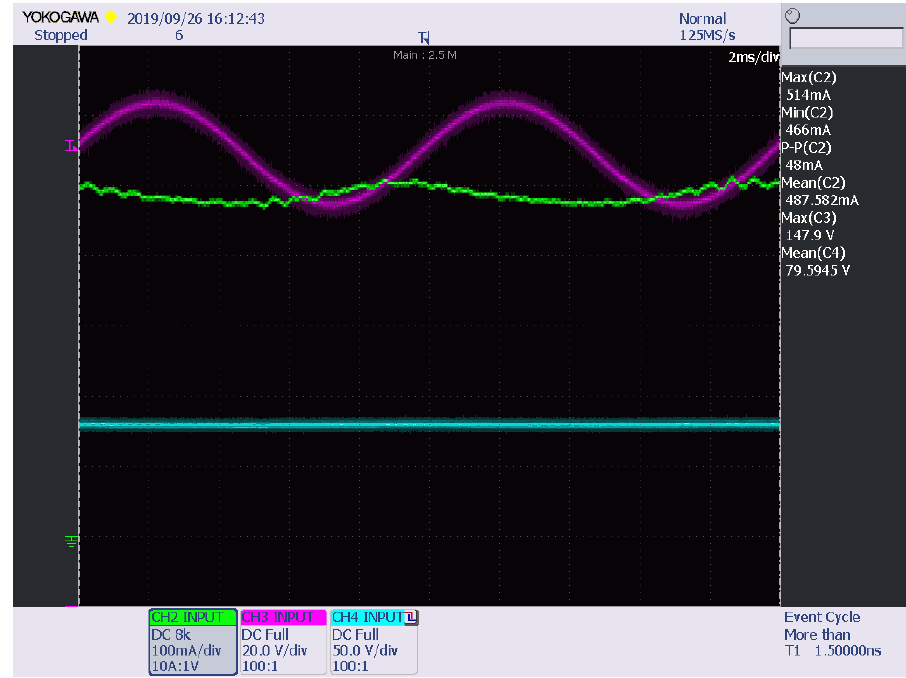
Figure 20. Experimental waveforms at nominal power with PI controller enabled. (4.9% ripple). Channel 2: LED current, green trace, 0.1 A/div; Channel 3: Bus voltage, magenta trace, 20 V/div; Channel 4: LED voltage, cyan trace, 50 V/div.